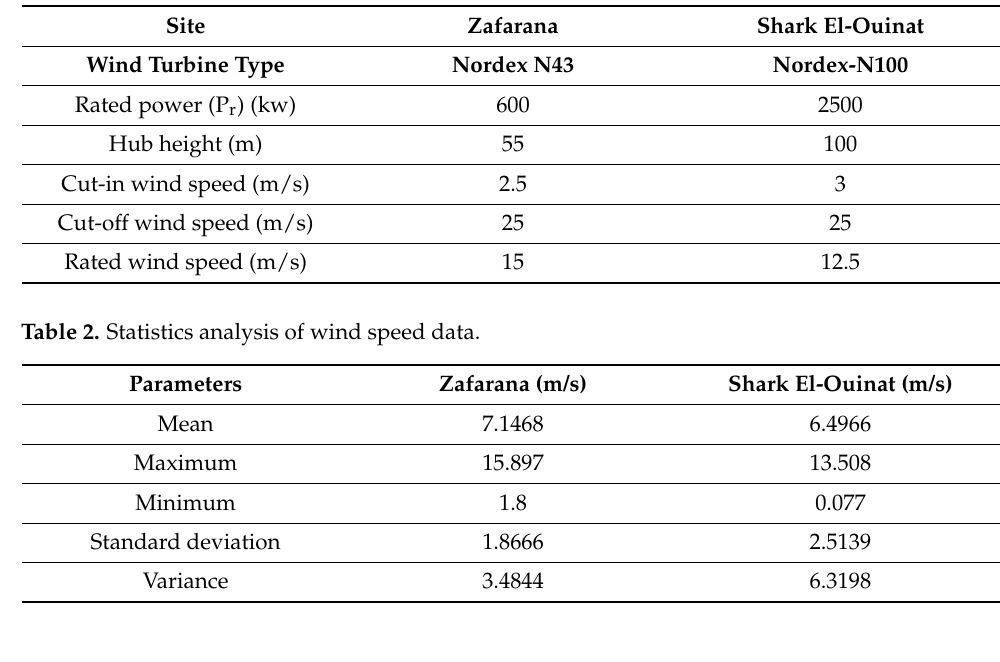
Table 1. Wind turbine characteristics.